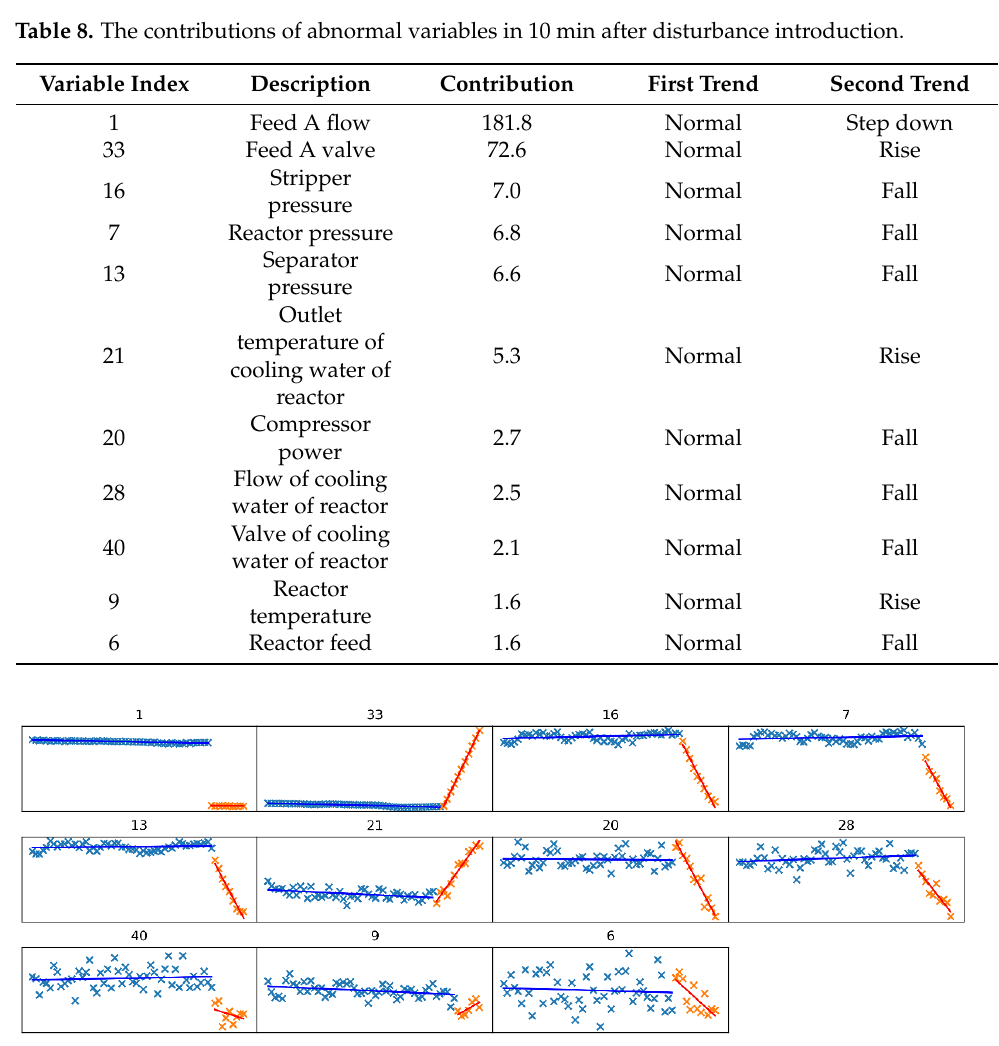
Figure 14. The linear fitting of abnormal variables in 10 min for Mode 5 fault 6.